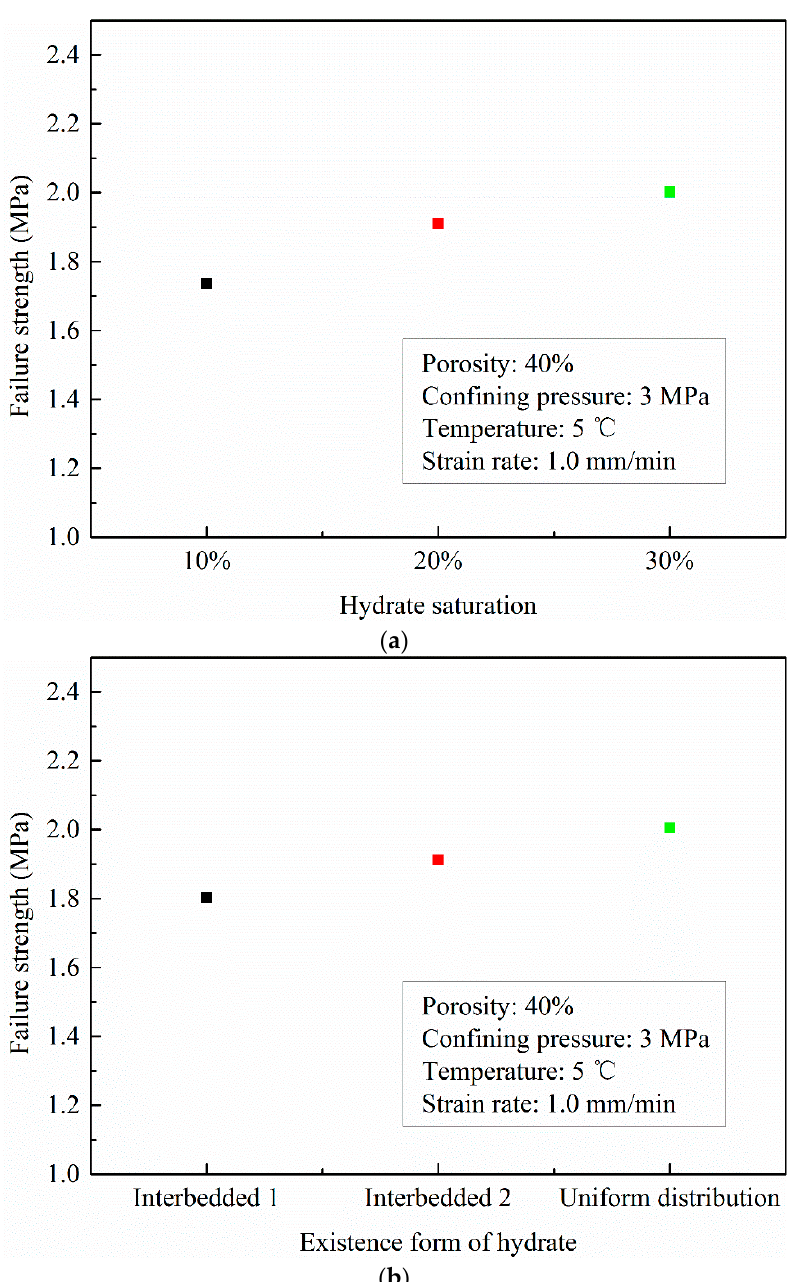
Figure 11. Failure strength of HBMS: ( a ) with different hydrate saturations; ( b ) in different existence forms of hydrate.